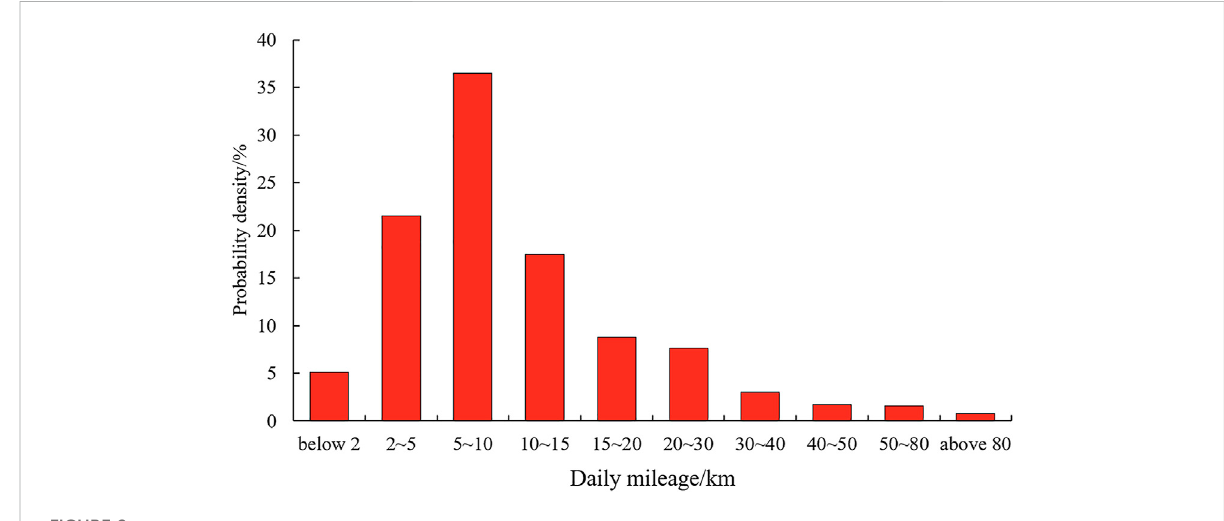
FIGURE 2 Probability density of electric vehicle average